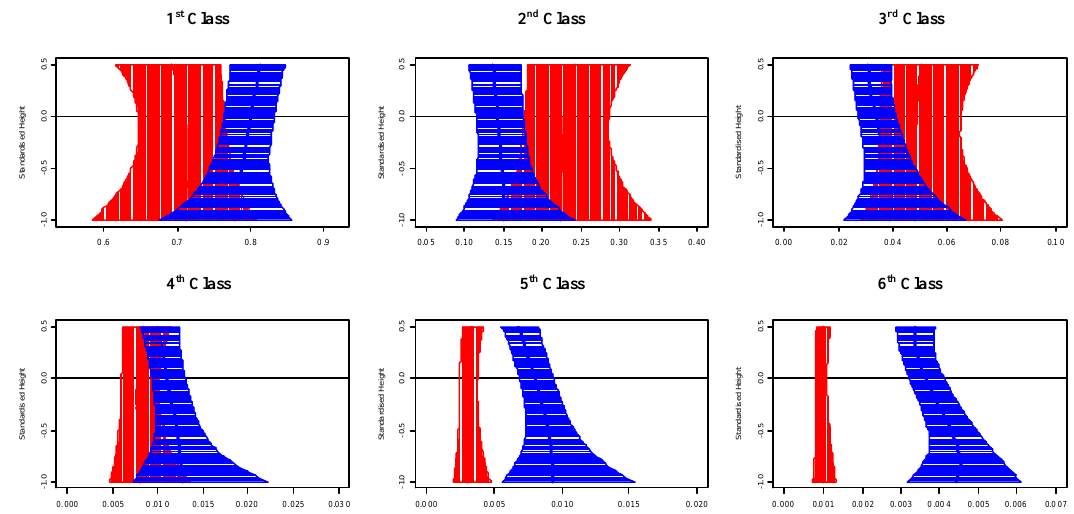
Fig. 12. 80% credibility bands for typical vertical profiles estimated for groups A (red) and C (blue).